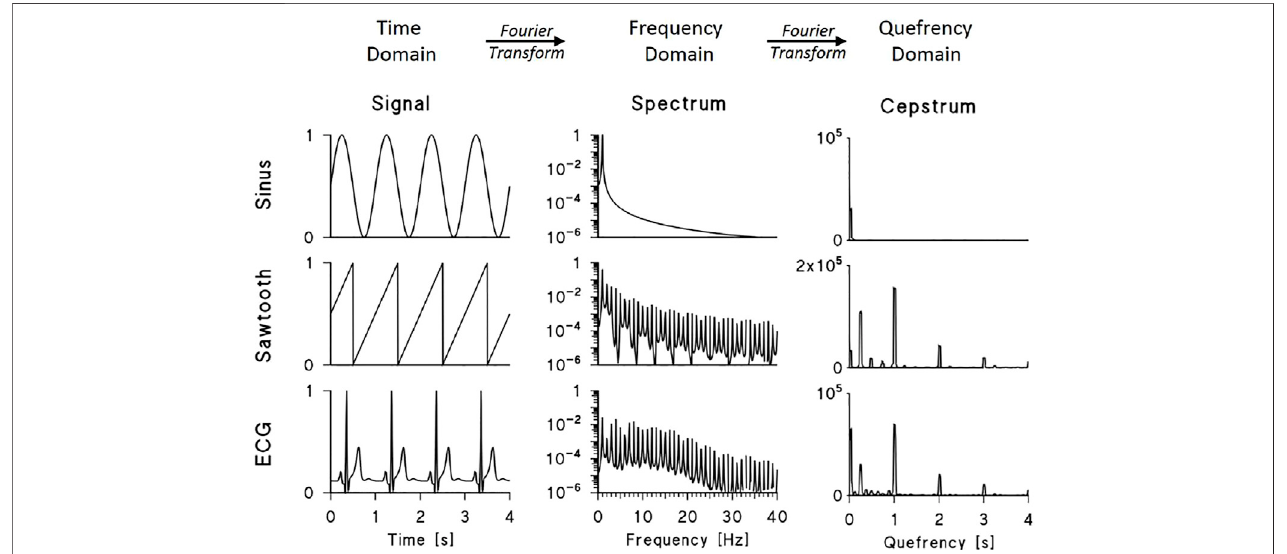
FIGURE 1 | Power spectra and power cepstra of a sinusoid, sawtooth function and synthesised ECG. The signals were sampled at 200 Hz, the spectra were calculated over 2048 points by Fast Fourier Transform (FFT) and the cepstra were calculated by FFT of the log-transformed spectra between 0 and 100 Hz (for clarity, spectraare plotted upto40 Hz, signals and cepstraupto 4 s). The cepstra ofthesawtooth function and synthesizedECG showpeaks at 1,2, and 3 s representing the train of power spectrum harmonics multiple of the fundamental frequency f 0 = 1 Hz; the sawtooth cepstrum also shows peaks at 0.24 s and its multiples representingthemodulationwithperiod of4.2 Hzvisibleinitslog-spectrum; theECGcepstrumshowsalarge peakatthelowestquefrencyrepresenting thedecreasing spectral trend.